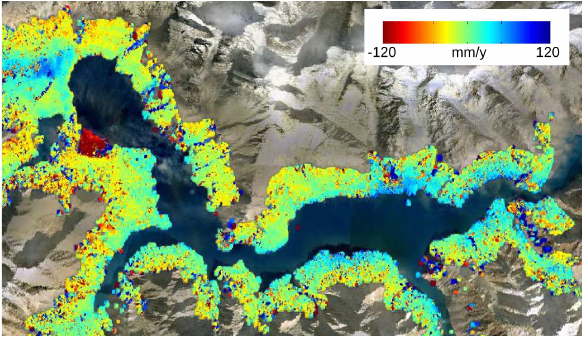
Figure 4. Small Baseline approach for detection of landslide(s) at Sarez lake, Tajikistan from S-1A data.